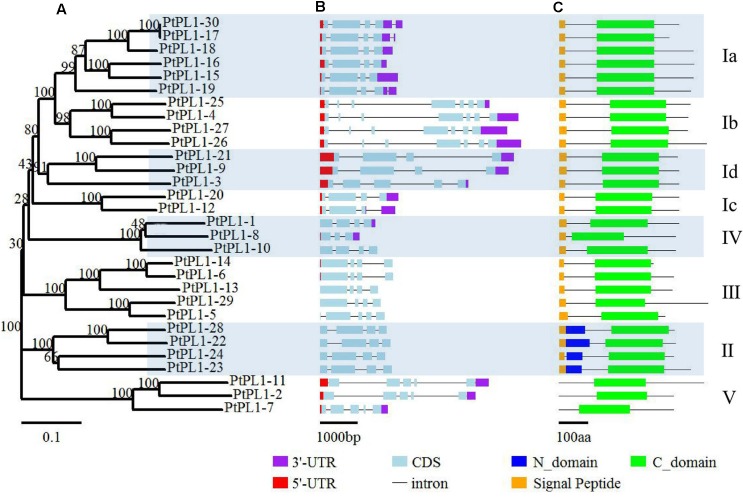
Phylogenetic relationships, gene structure and conserved domains of PtPL1 gene family. The 30 full-length PtPL1 protein sequences were aligned by ClustalX2, an un-rooted Neighbor-Joining (NJ) tree (A) was developed by the MEGA5.0.5 program. Bootstrap analysis was performed with 1000 iterations, numbers on the nodes indicated clade credibility values. PtPL1-1 to PtPL1-28 were previously identified by Geisler-Lee et al. (2006) and PtPL1-29 was identified by Biswal et al. (2014). PtPL1-30 is a novel gene in this study. The subgroups followed Biswal et al. (2014) Gene structures of PtPL1 family genes were shown in color scheme (3′-UTR in purple, 5′-UTR in red, exon in blue) (B). Conserved domains in PtPL1 proteins were predicted by SMART website (http://smart.embl-heidelberg.de/) (C). Green boxes: Pec_lyase_C domain (C-domain); Dark blue boxes: Pec_lyase_N domain (N-domain); Yellow boxes: Signal peptide.